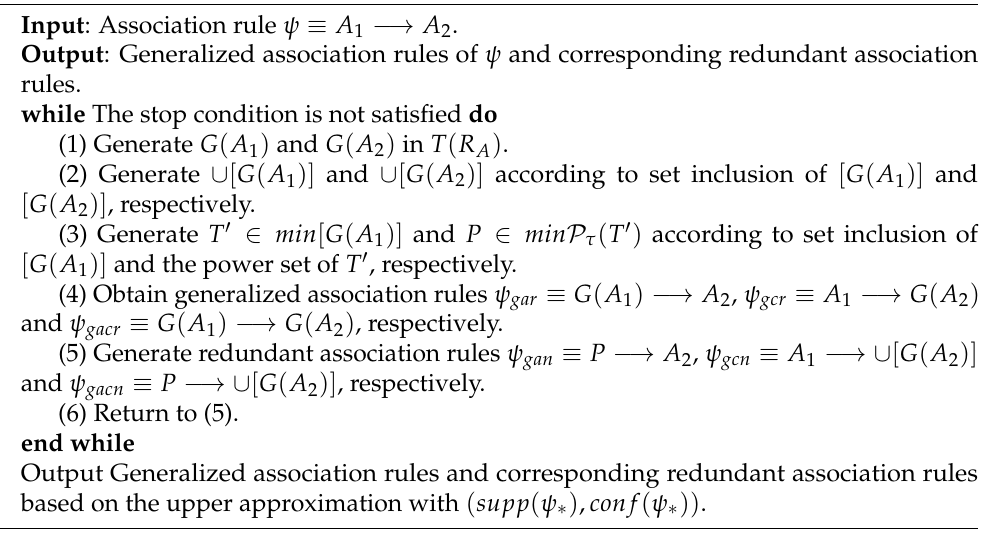
Algorithm 4 Mining generalized association rules and redundant association rules based